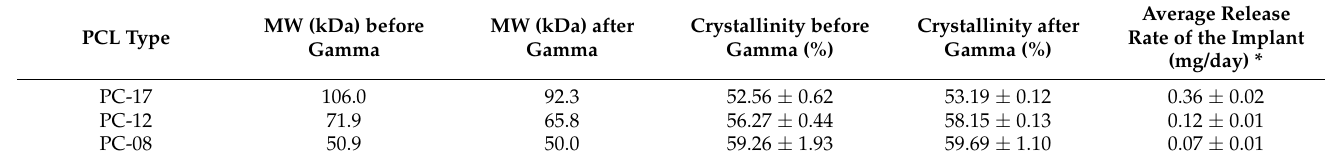
Table 1. The weight average MW and crystallinity of tubes extruded from different non-blended PCL types (PC-08, PC-12, PC-17) as determined by DSC, and the average release rates of TAF from implants fabricated with tubes of these PCL types. Implants contain a formulation of 2:1 TAF/sesame oil and tubes have a wall thickness of 100 µ m, a length of 40 mm, and an OD of 2.5 mm. The in vitro release assessments were performed in triplicates. The MW and % crystallinity were determined using hollow extruded tubes without drug formulations. The % crystallinity reflects the mean values ± standard deviation of three independent measurements, whereas the MW value was reported based on one measurement.